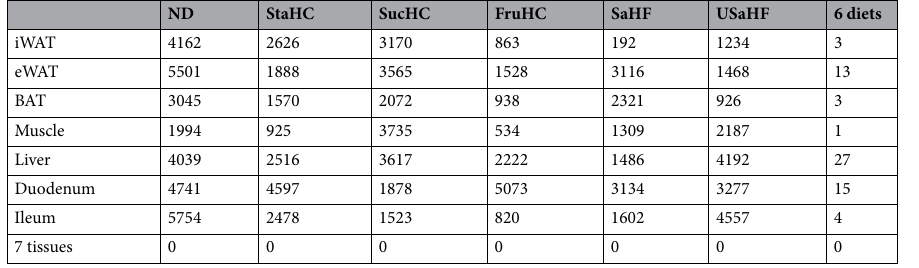
Table 1. Number of differentially expressed genes (DEGs) between germ-free mice and fecal microbiota- transplant mice fed six different diets. DEGs in seven tissues were screened using the criteria of p < 0.05 and fold change > 1. Six diets, the number of DEGs common across all diet groups; seven tissues, the number of DEGs common across all tissues within a diet group; iWAT, inguinal white adipose tissue; eWAT, epididymal white adipose tissue; BAT, brown adipose tissue; muscle, skeletal muscle; ND, normal diet; StaHC, high-starch diet; SucHC, high-sucrose diet; FruHC, high-fructose diet; SaHF, saturated fatty acid-rich high-fat die; USaHF, unsaturated fatty acid-rich high-fat